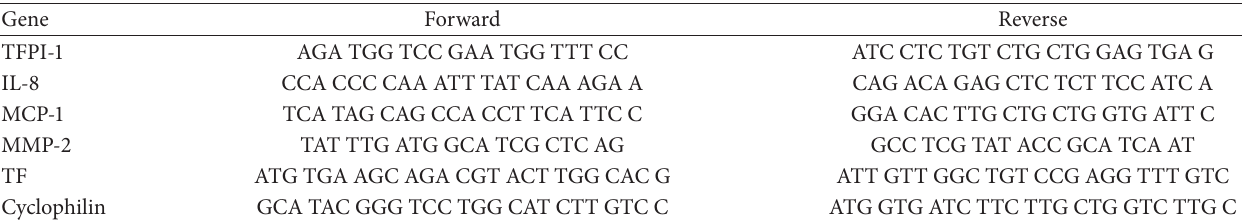
Table 1: Sequences of primers